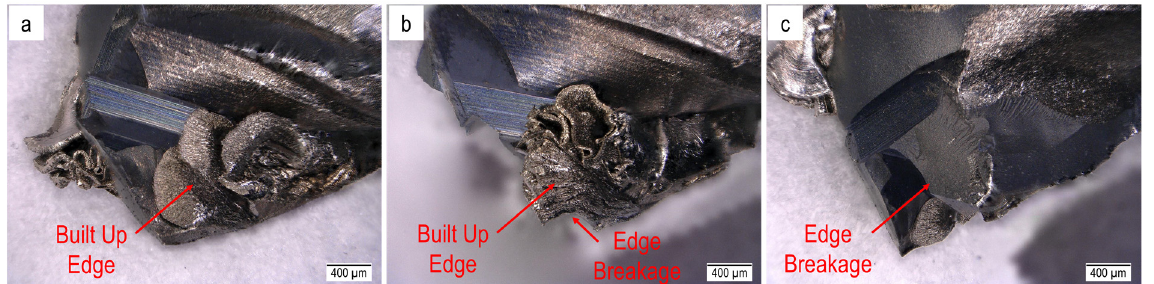
Figure 6. BUE and tool breakage at v c = 80 m/min and f z = 20.6 µm/tooth ( a ) edge 1; ( b ) edge 2; ( c ) edge 3.